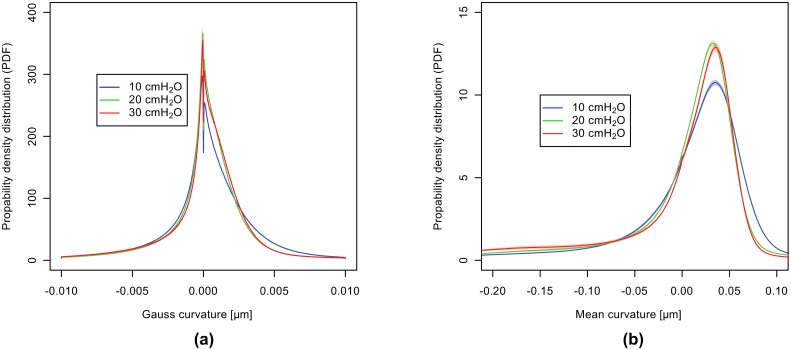
Gaussian and mean curvatures PDF.Probability density functions (PDF) of Gaussian (a) and mean (b) curvatures. Like before, the uncertainty intervals arise from the different segmentation parameters.